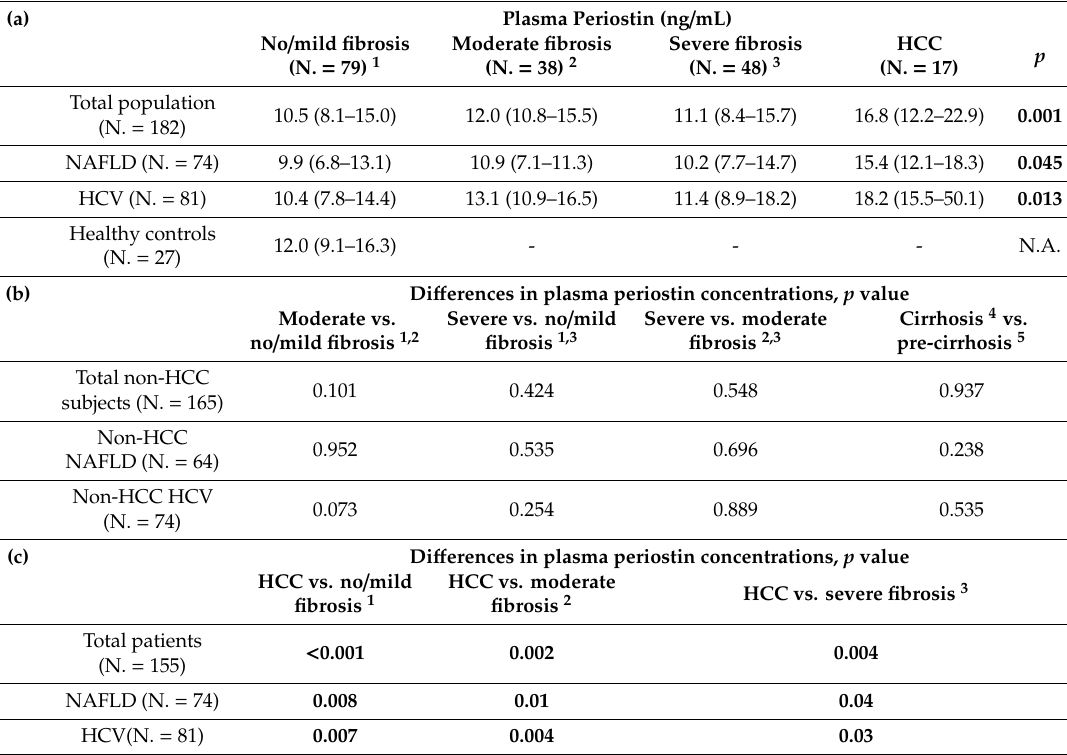
Healthy controls (N. =